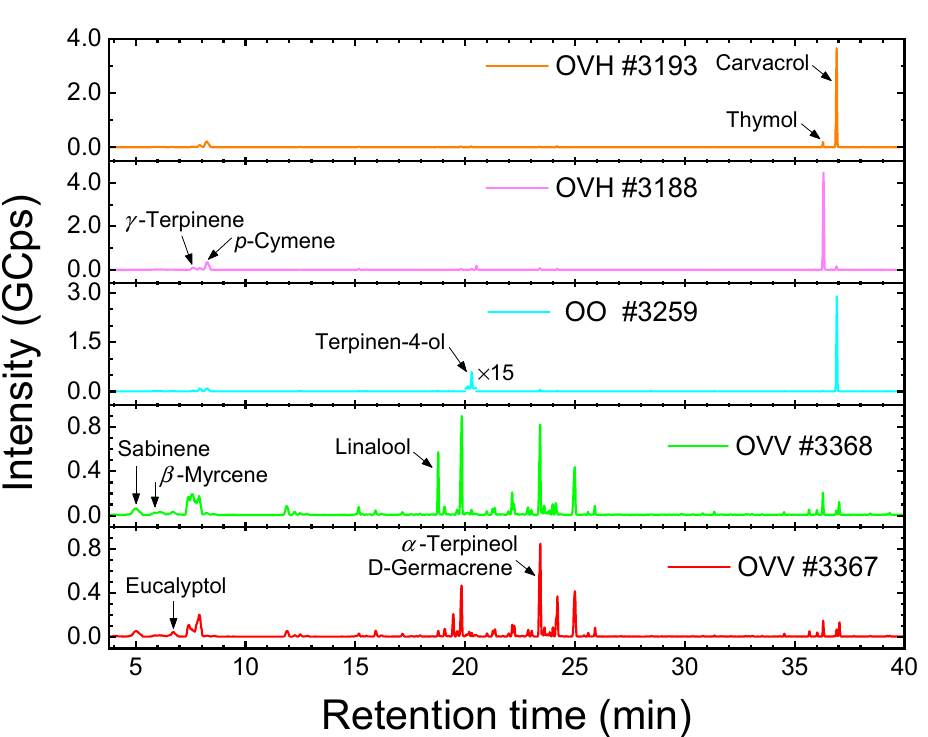
Figure 4. HS GC-MS chromatograms of the investigated Origanum essential oils, originating from plants identified as Origanum vulgare subsp . vulgare (OVV, #3367 and #3368), Origanum onites (OO, #3259) and Origanum vulgare subsp . hirtum (OVH, samples #3188 and #3193). Arrows indicate peaks corresponding to the available reference compounds (Table 2). α -Terpineol practically coelutes with D-germacrene [28]. The chromatogram of sample #3259 in the vicinity of the terpinen-4-ol peak has been appropriately magnified to enhance readability.